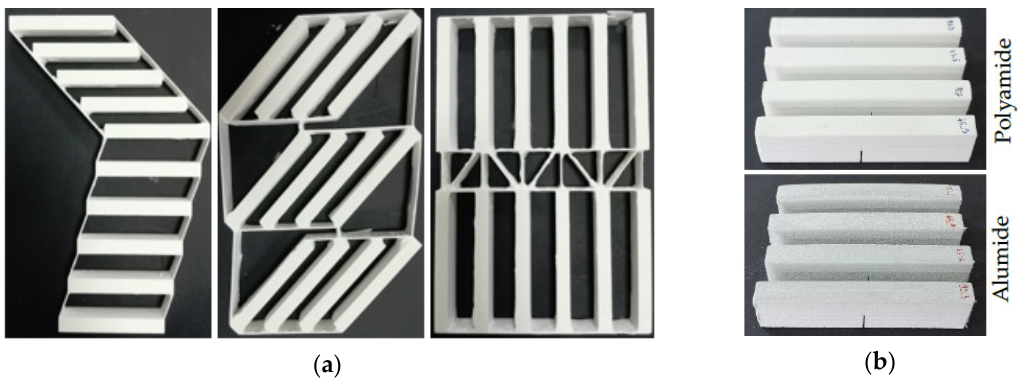
Figure 1. Samples after post-processing oriented at 0°, 45° and 90°, respectively ( a ) and notched polyamide and Alumide samples ( b ).